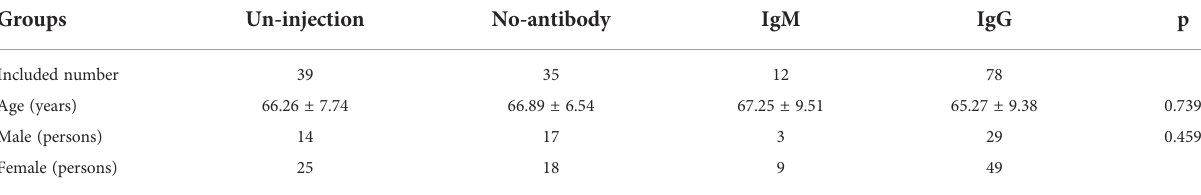
TABLE 1 General information for the included age-related cataract patients. Groups